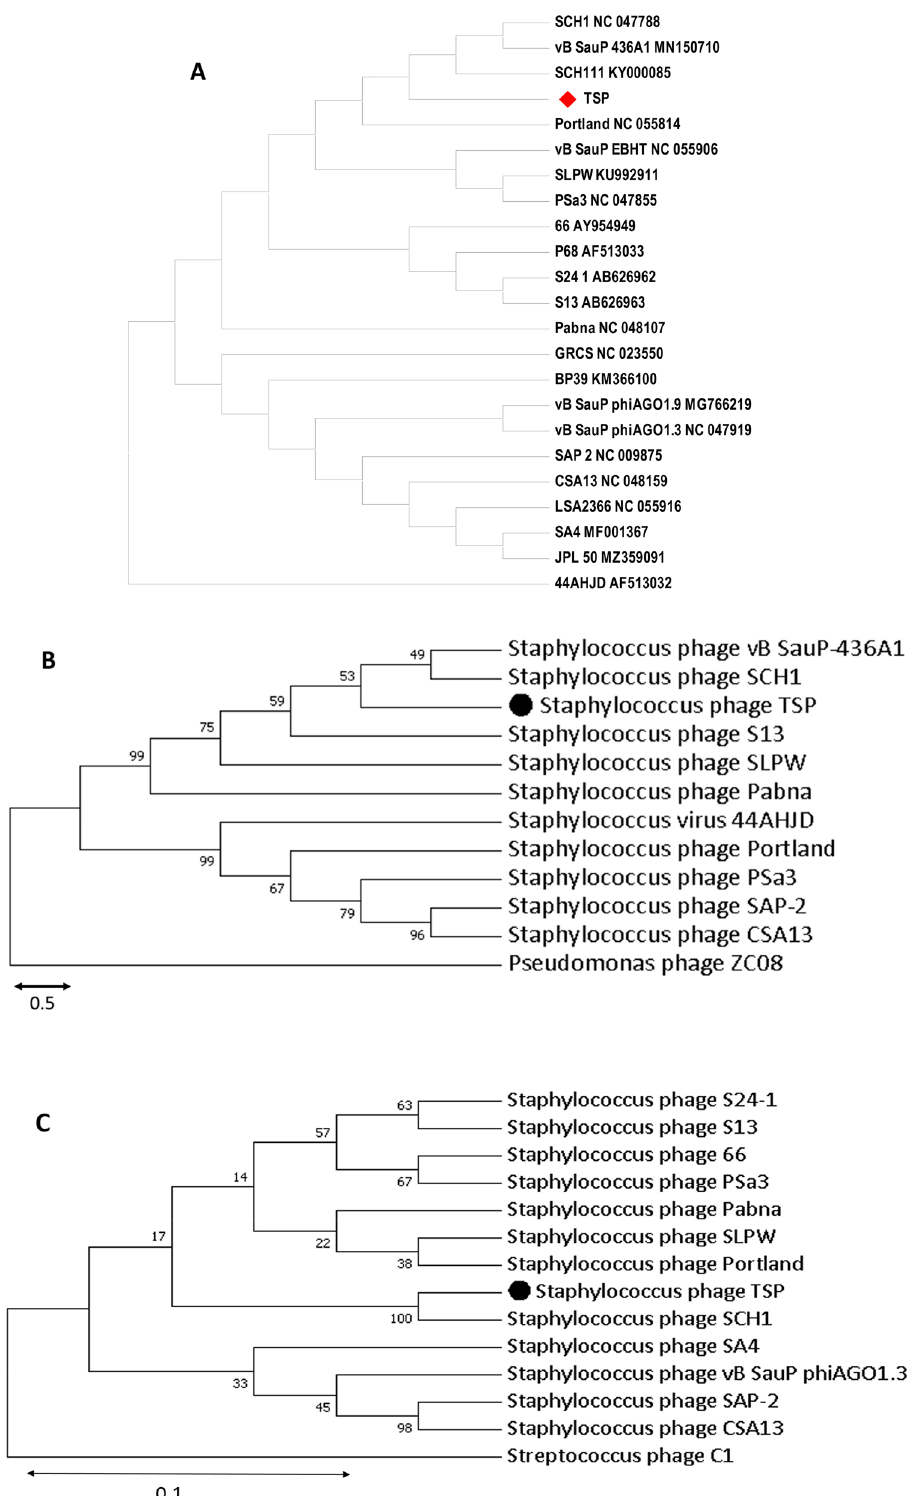
Figure 7. ( A ) Comparative genomic analysis of S . aureus phages. Whole genome sequences were used to construct a phylogenetic tree in Victor, an online tool. The red tilted square box highlights the phage TSP. Phylogenetic analysis of TSP based on the amino acid sequences of major capsid ( B ) and DNA polymerase ( C ). Phylogenetic trees for phage proteins were constructed with the alignment tool UPGMA with a bootstrap value of 2000. Pseudomonas phage ZC08 and Streptococcus phage C1 act as an outgroup. The scale bar represents 0.5 and 0.1 fixed mutations per amino acid position.The dark dot highlights newly isolated phage